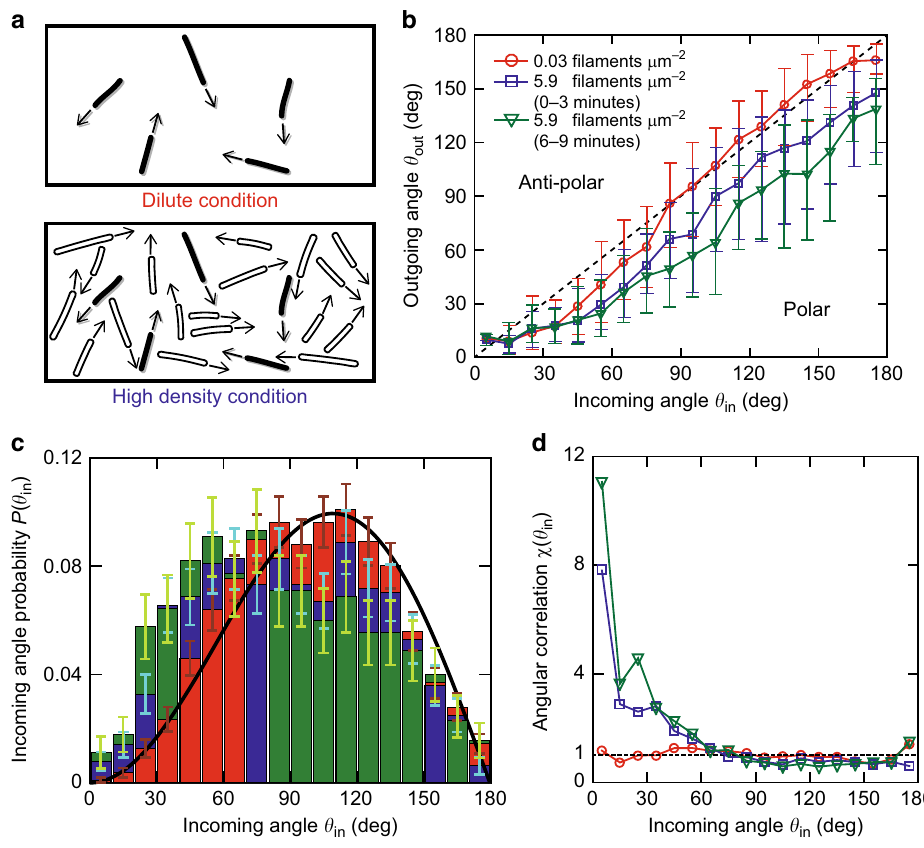
Fig. 2 Effective binary collision statistics. a Schematic of effective binary collision experiment. While in the dilute condition all fi laments are labelled ( top ), at high fi lament density condition the labelled fi laments are put in a pool of unlabelled fi laments ( bottom ). The binary collision is evaluated for the labelled fi laments. b Effective binary collision statistics at high fi lament density compared to a dilute system (data taken from ref. 31 ). Here, the result for 0.03 fi laments μ m − 2 ( red open circles ) and 5.9 fi laments μ m − 2 before cluster formation ( blue open squares : 0 – 3 min N 0 (cid:3) 3 min ¼ 641, green open downward triangle : ρ ¼ 5 : 9 ¼ 452) are shown. The dashed line represents collisions that are unaffected ( θ = θ 6 – 9 min N 6 (cid:3) 9 min ρ ¼ out in ). Above this line ( top-left ), the collisions are anti- 5 : 9 polar in nature, whereas below it ( bottom-right ) they are polar. Large enhancement in polar alignment suggests the existence of small patches of locally aligned fi laments. This enhancement becomes more apparent later on in time but before the clusters emerge. Error bars: s.d. c Incoming angle statistics for the effective binary collision experiment. For higher fi lament density, the small incoming angles increase. Also with time, small incoming angles increase. Black solid line shows the theoretical incoming angle probability, characterized by the Boltzmann scattering cylinder for slender rods (see text). Same colours as in b . Error bars: ± ( N bin ) 1/2 . d Angular correlation χ ( θ in ) calculated from P ( θ in )/ Γ ( θ in ) (see text for detail) using b and c . The angular correlation emulates a locally aligned patch of fi laments as χ ( θ in ) = 1 + C / θ in , where C = 0 ( χ = 1) corresponds to the molecular chaos assumption. For the dilute case, C ≈ 0 ( dashed line shows χ = 1), and a signi fi cant correlation for the condition 5.9 fi laments μ m − 2 , even before emergence of cluster. Same colours and symbols as in P ( θ in ) (Fig. 2c), which is experimentally obtained, and Γ ( θ in ) (Fig. 2c; black solid line ), the higher fi lament density condition shows clear signs of angular correlations (Fig. 2d); as the system is more polar (higher angular correlations), it is more likely to fi nd collisions that exhibit polar alignment tendencies than collisions in a random system. The change in the collision tendencies and incoming angle statistics over time in the high density pre-cluster regime clearly shows that orientational correlations intensify and alignment among fi laments become more and more notable, enabling growth of the polar structures to overcome orientational randomization and hence annihilation of the structures, analogous to seeding processes in equilibrium systems.